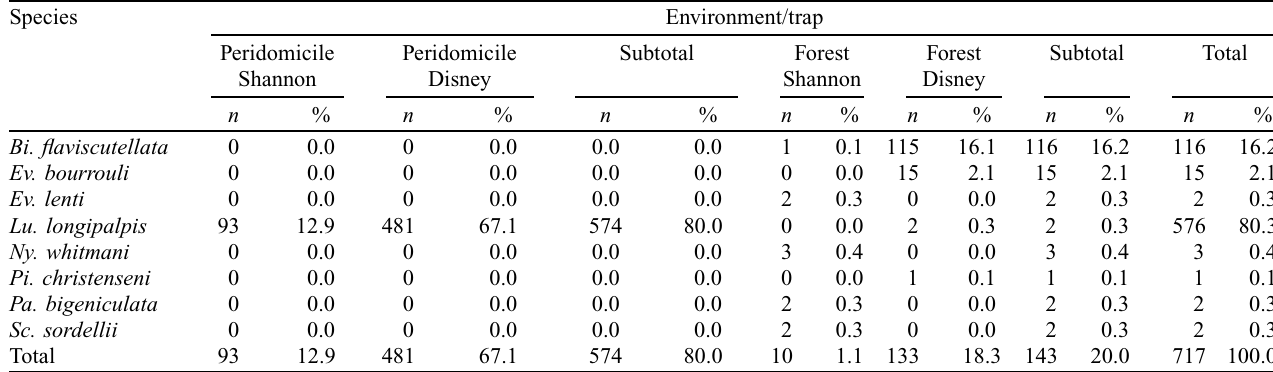
Table 2. Distribution of the phlebotomines collected in Shannon and modified Disney traps in peridomiciles and forest fragment, Campo Grande, Mato Grosso do Sul, Midwest Brazil, 2007–2009. Species